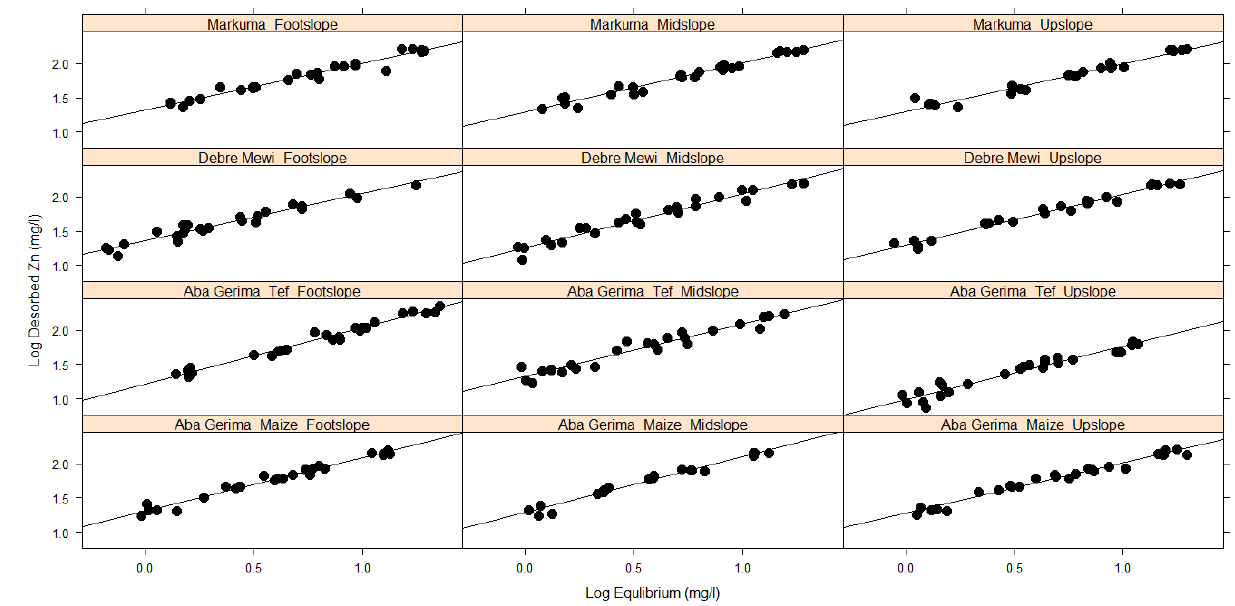
Figure 6. Desorption data fitted to the Freundlich isotherm.